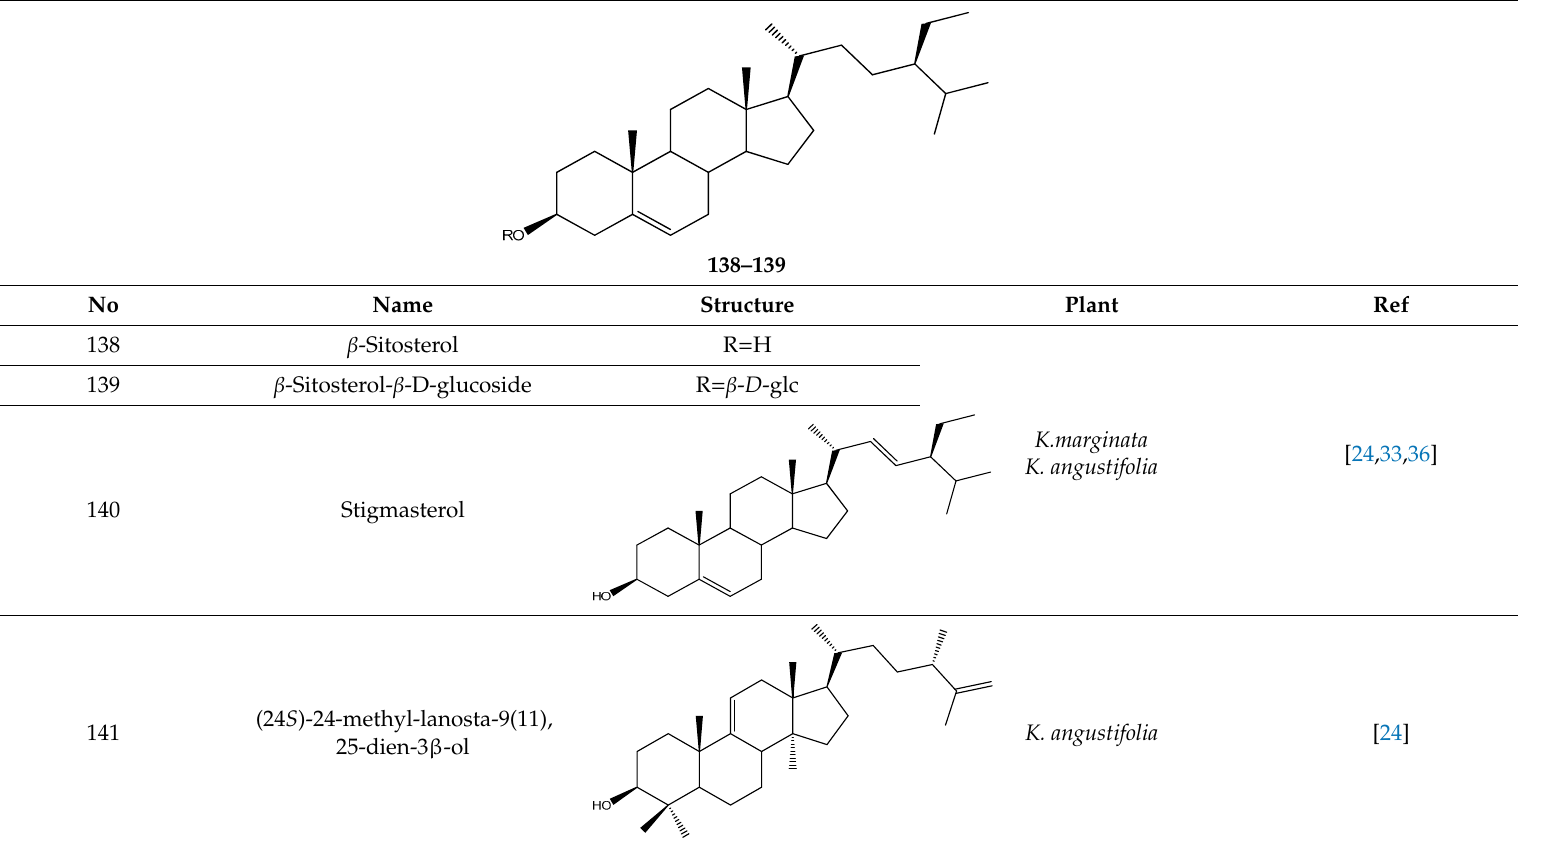
Table 3. Steroid and triterpenes.